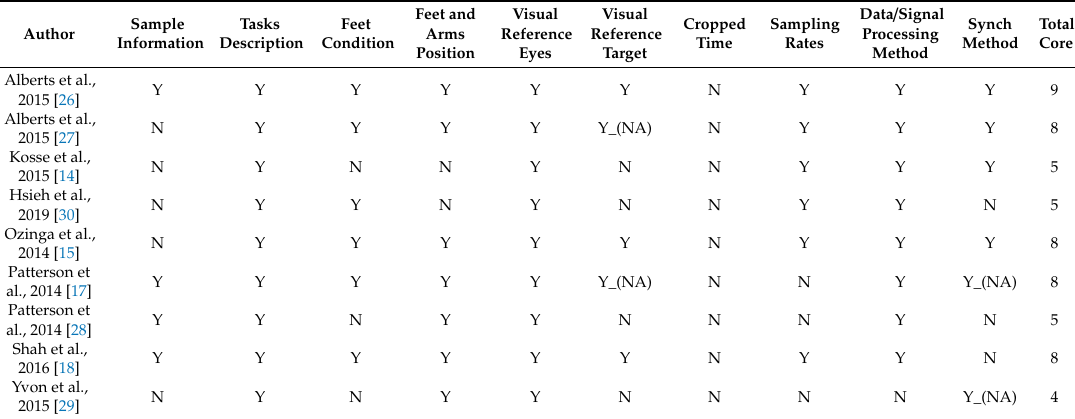
Table A2. Results of the 10-Point Checklist for Balance Assessment tool of the 9